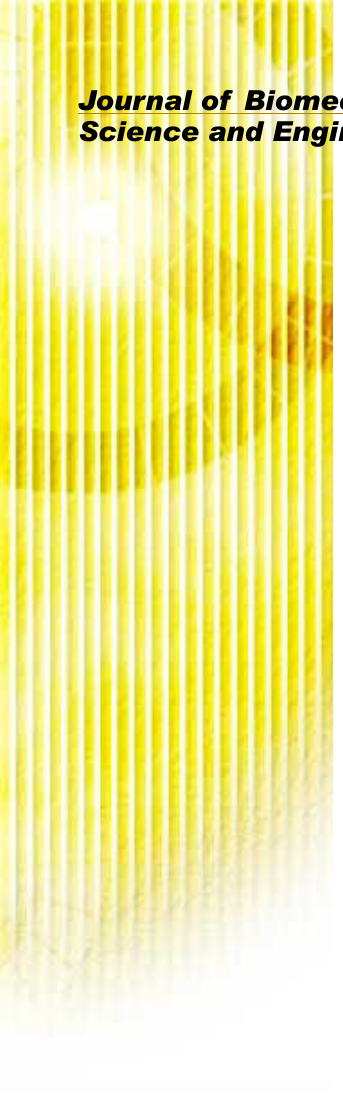
boneBone Digital image of trabecular